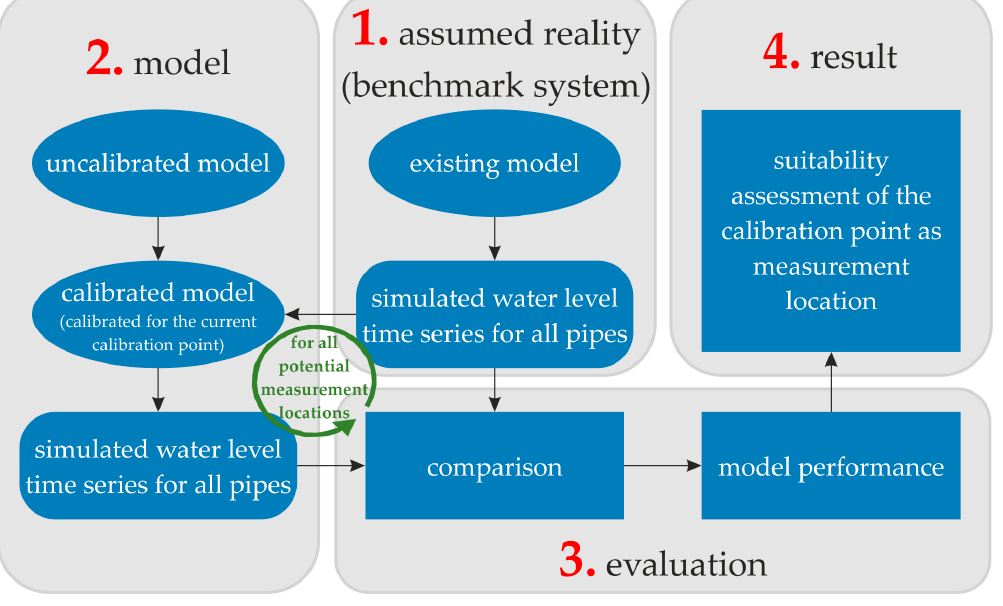
Figure 4. General scheme of the first approach.